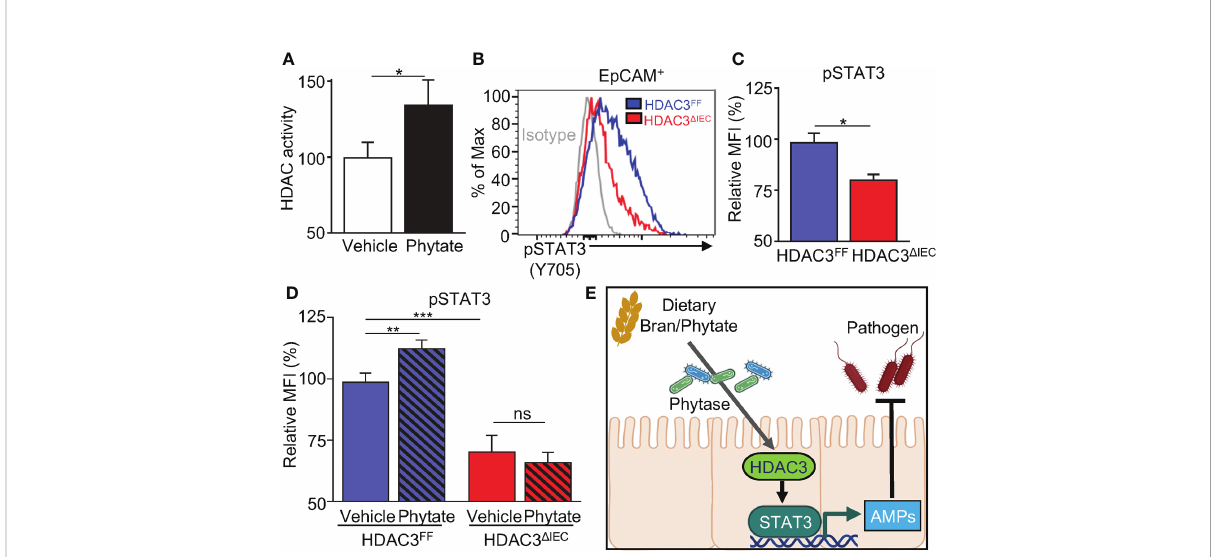
FIGURE 6 Phytate-mediated epithelial STAT3 activation requires HDAC3. (A) Intestinal epithelial HDAC activity of vehicle- or phytate-treated mice. (B) Representative fl ow cytometry plots from IECs of vehicle- or 2% phytate-treated mice, gated on live EpCAM + cells. (C) Mean Fluorescence Intensity (MFI) of pSTAT3 (Y705), normalized to FF. (D) MFI of IEC pSTAT3 of vehicle- or 2% phytate-treated HDAC3 FF or HDAC3 D IEC mice, normalized to FF-vehicle. (E) Through phytate metabolism by microbial phytases, rice bran and its component phytate activate IEC STAT3 and downstream defense mechanisms against enteric infection. Data are representative of 2-3 independent experiments. n=4 per group. Results are mean ± SEM. * p < 0.05, ** p < 0.01, *** p <